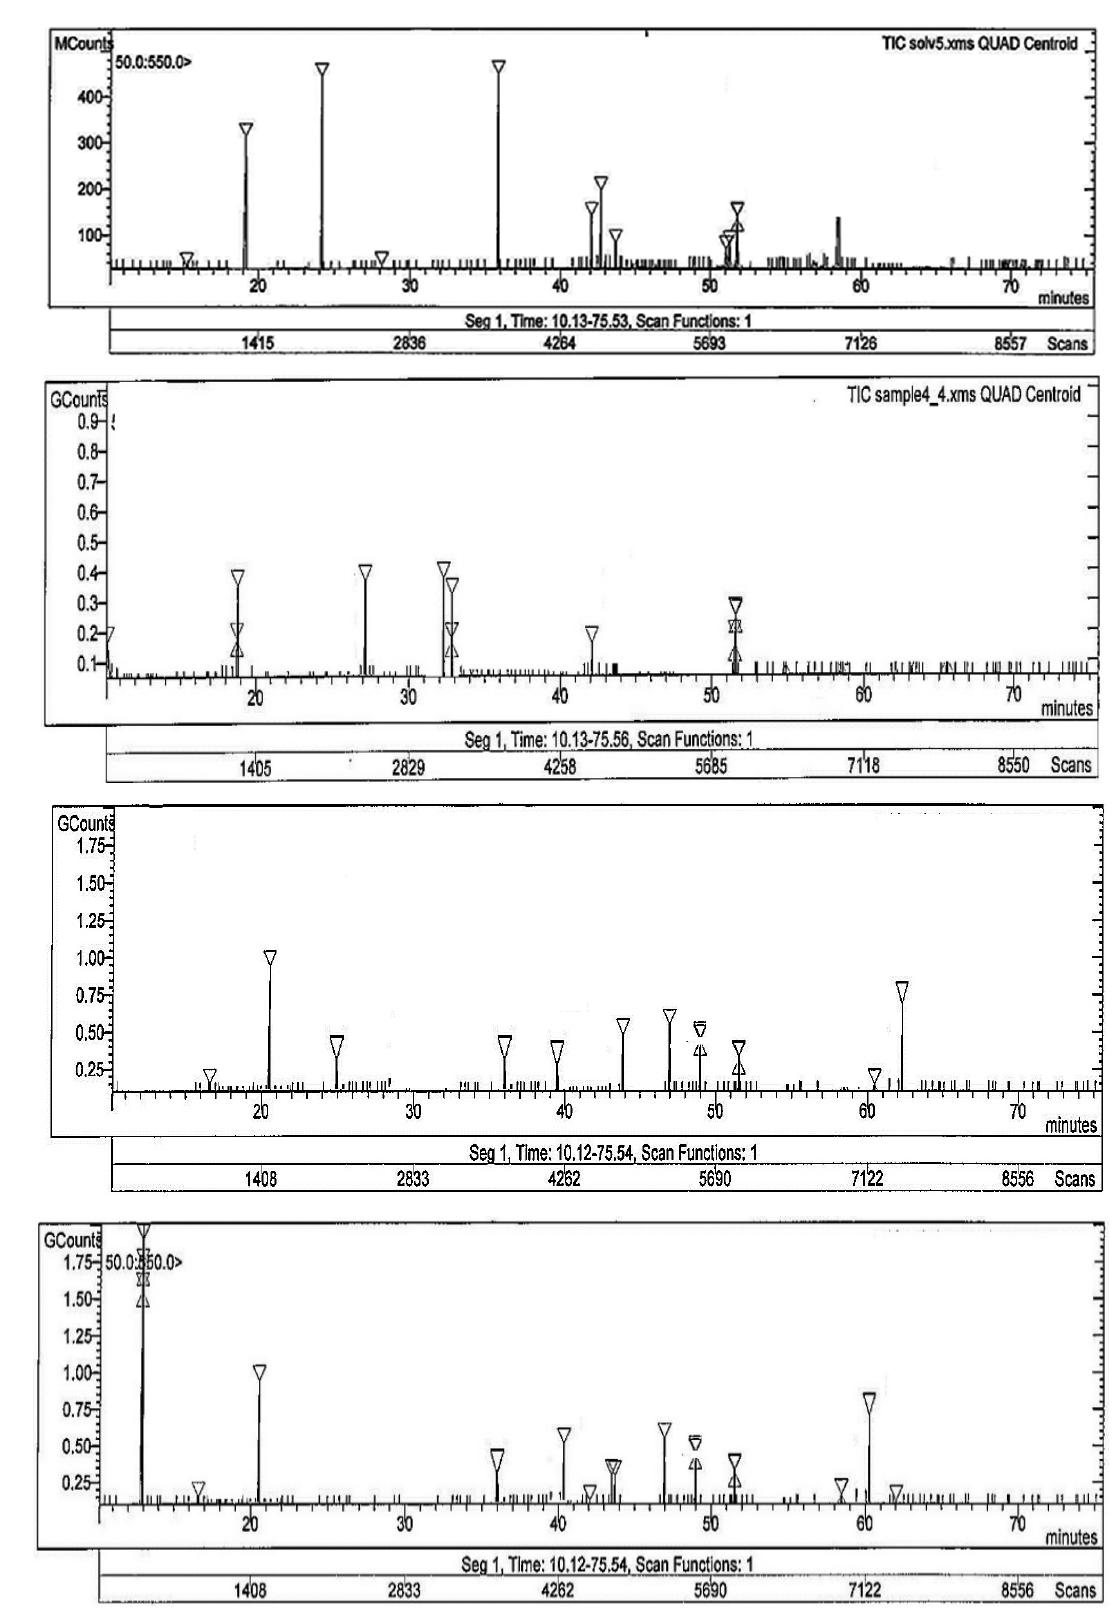
Figure 2. HPLC analysis of the flavonoid compounds in the different organs as well as the solid distillation wastes of Taif’s rose collected from Al-Shafa highlands in Taif City, Saudi